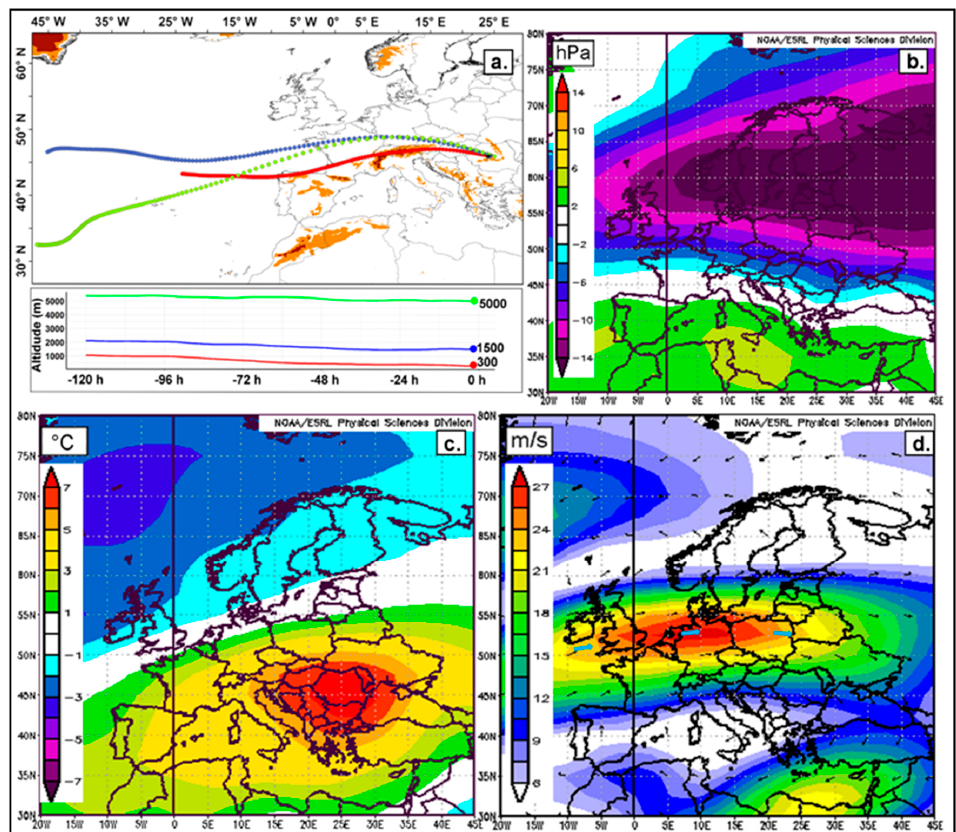
Figure 6. ( a ) Mean five-day backward trajectories of air particles before the first day of B3 HW/WS type; ( b ) composite sea level pressure anomaly; ( c ) composite air temperature anomaly at 850 hPa; and ( d ) composite jet stream mean position anomaly at 300 hPa for B3 HW/WS